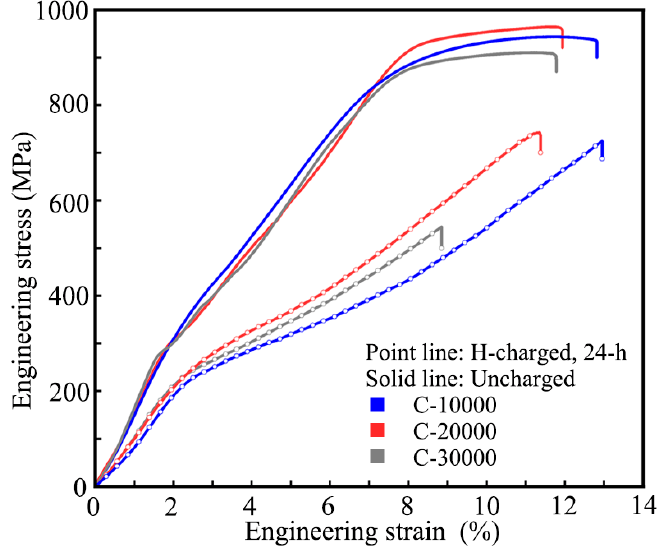
Figure 6. Engineering stress–strain curves of the TC4 welded joints with and without hydrogen filling at varying levels of fatigue damage.